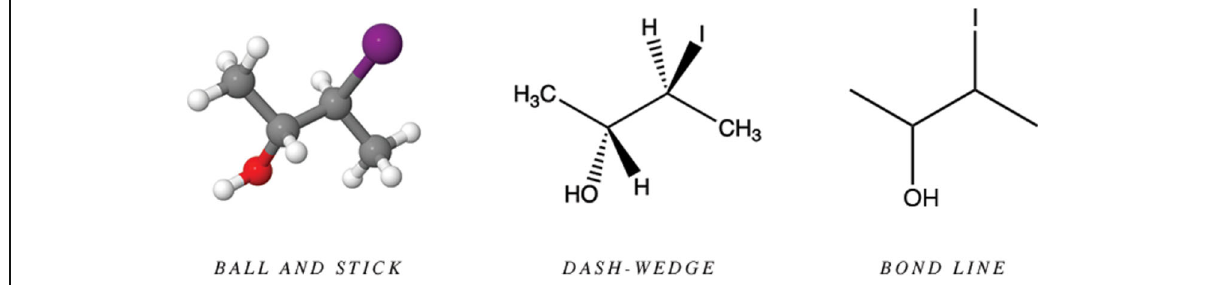
Fig. 2 Equivalent representations of